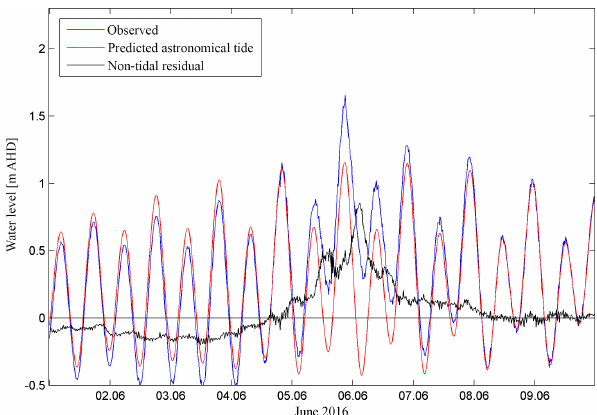
Figure 2. Observed water level at Crookhaven Heads gauge (blue), predicted astronomical tide (red) and non-tidal residual (black) in m AHD, during the June 2016 storm